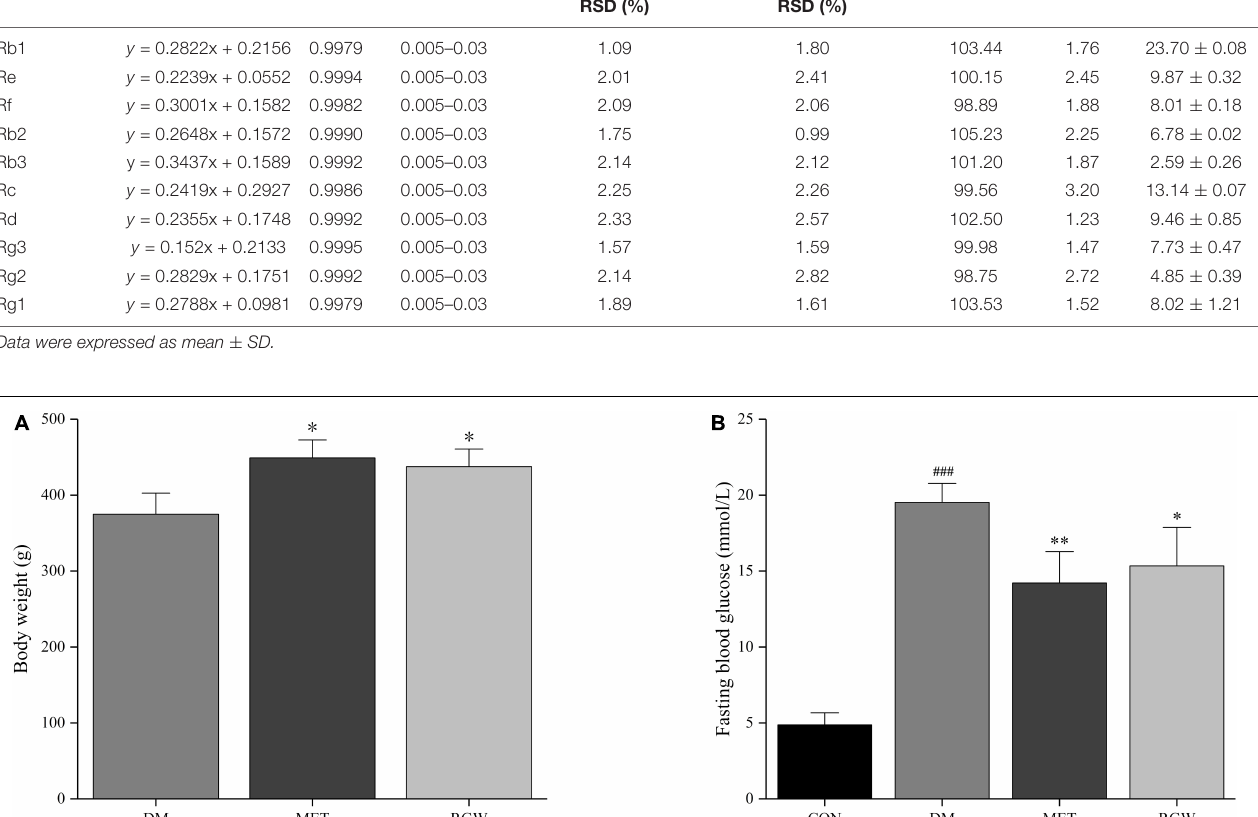
TABLE 2 | Calibration curves, accuracy, precision, and content for 10 ginsenosides ( n = 6). Ginsenosides Calibration curve